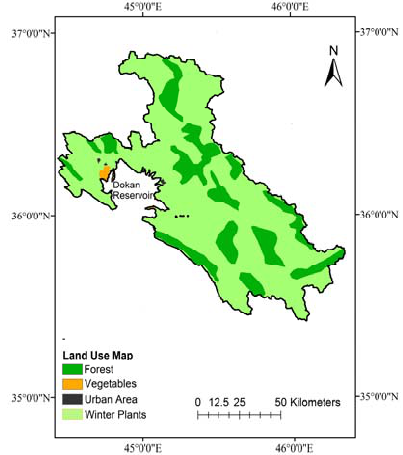
Figure 3. Land use and land cover classification of the Dokan Reservoir watershed.